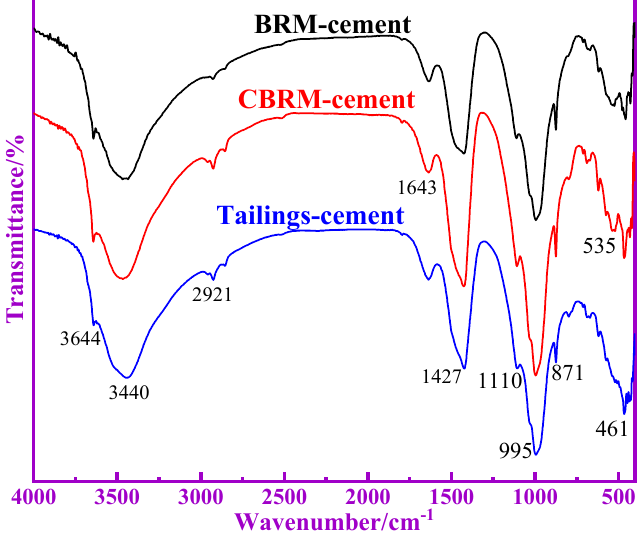
Figure 9. FTIR absorption spectra of BRM-cement, CBRM-cement, and Tailings-cement. The absorption peaks at 3643 cm − 1 and 1637 cm − 1 indicate the telescopic and free- water bending vibrations of Ca(OH) 2 , respectively [21]. The absorption peaks of Tailings- cement at 3644 cm − 1 and 1643 cm − 1 weaken, implying that more Ca(OH) 2 is involved in the hydration reaction, and more free water is changed to bound water during the